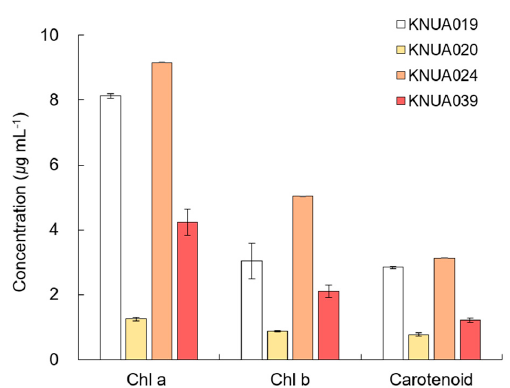
Figure 4. Chlorophyll a (Chl a), chlorophyll b (Chl b), and total carotenoid concentrations of microalgal strains after maximum total nitrogen removal in treated, primary settled wastewater.